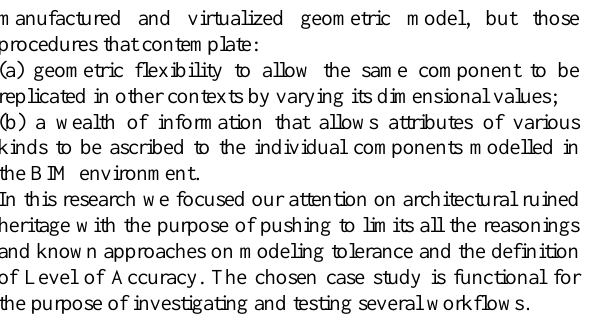
Figure 3. Church of Santa M aria delle Grazie after the digging campain and the first walls consolidation works.